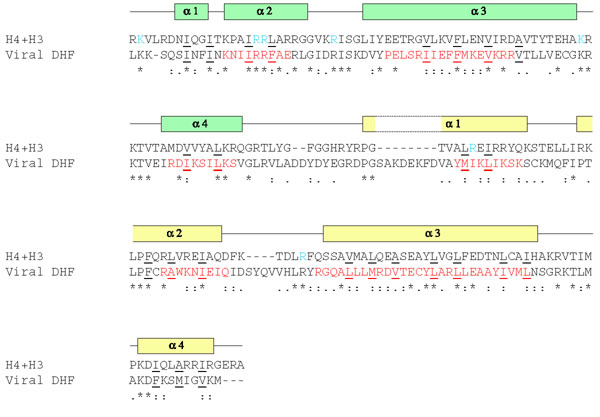
sequence alignment between "chimeric" H4-H3 histone and the double histone fold (DHF) from Heliothis zea virus 1. Above the alignment, are shown the positions of alpha-helices in histone H4 (green boxes) and histone H3 (yellow boxes). Red letters indicate regions predicted to assume an alpha-helical structure, based on a comparison among the results obtained from three different secondary structure prediction servers (PHD, J-pred, Psi-pred; see Methods). Light blue letters correspond to the basic residues which mediate the contact between the H3-H4 histone dimer and DNA. Underlined residues belong to the pattern of aminoacids whose hydrophobicity is strictly conserved.